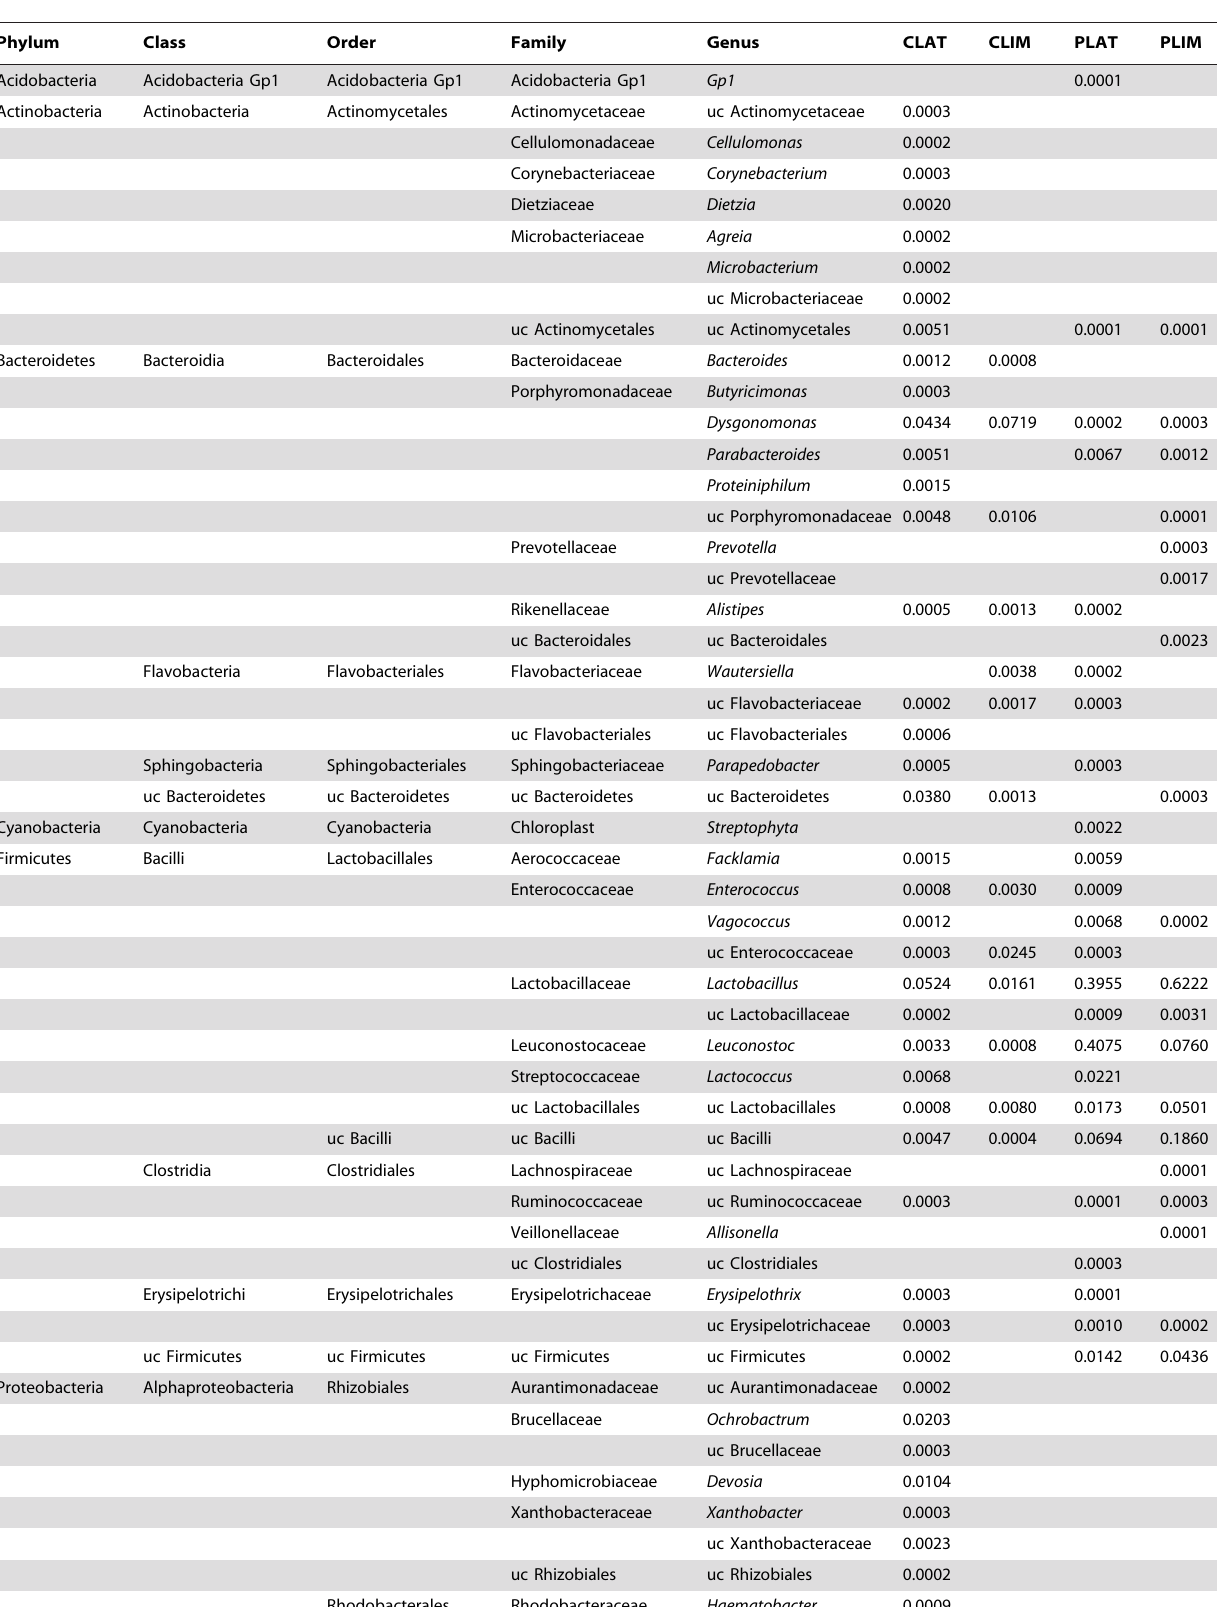
Table 2. Taxonomic composition of the samples (percentage of sequences belonging to each bacterial genus).